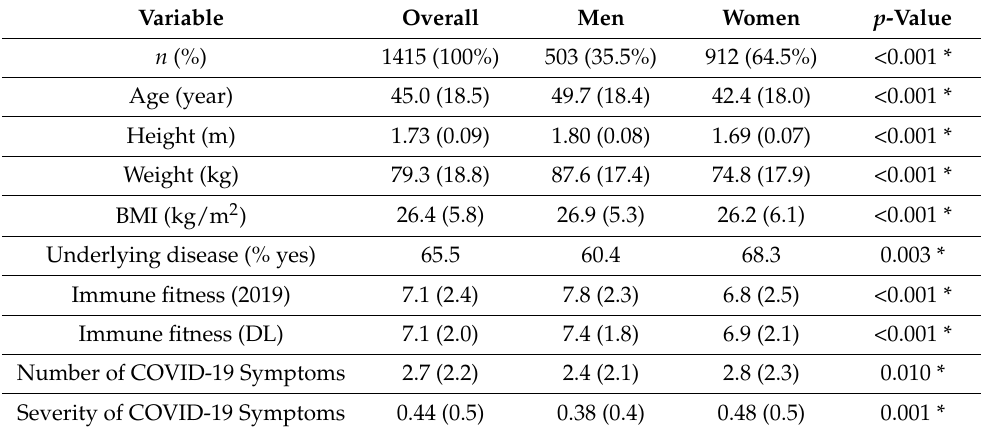
Table 1. Demographics and study outcomes of the CLOFIT